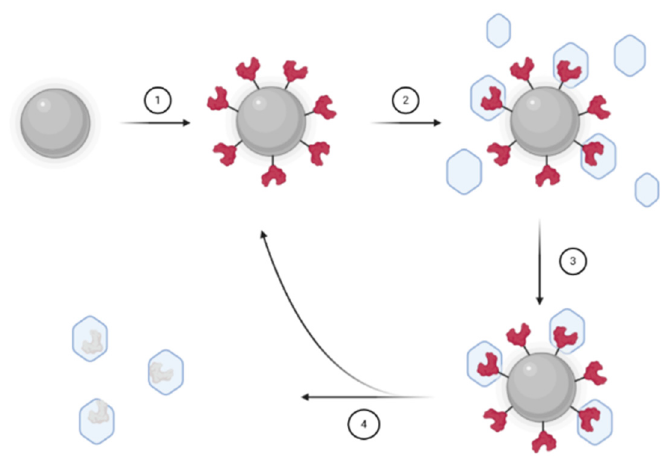
Figure 4. Solid phase synthesis technique: (1) the template is covalently coupled to glass beads, (2) a monomer mixture is added, polymerization is initiated, (3) non-specific polymers are washed using cool water, (4) release of specific polymers through hot washing, the swelling of the thermosensitive polymer allows the separation, the glass beads can be collected for a new polymerization. Created with BioRender.com the 3 rd April 2021.